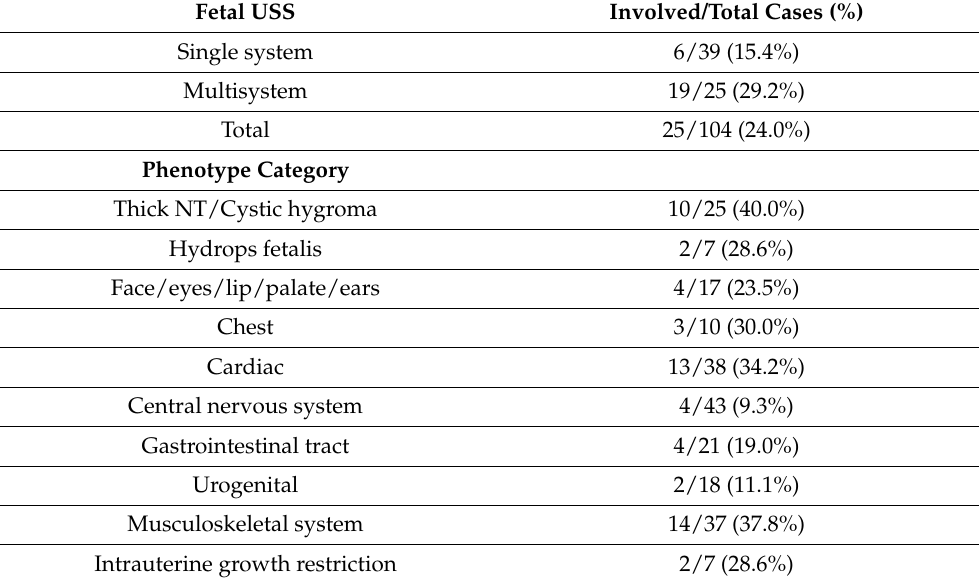
Table 3. Proportion of diagnosed fetuses ( n = 25) in each phenotype/SCA category. Fetal